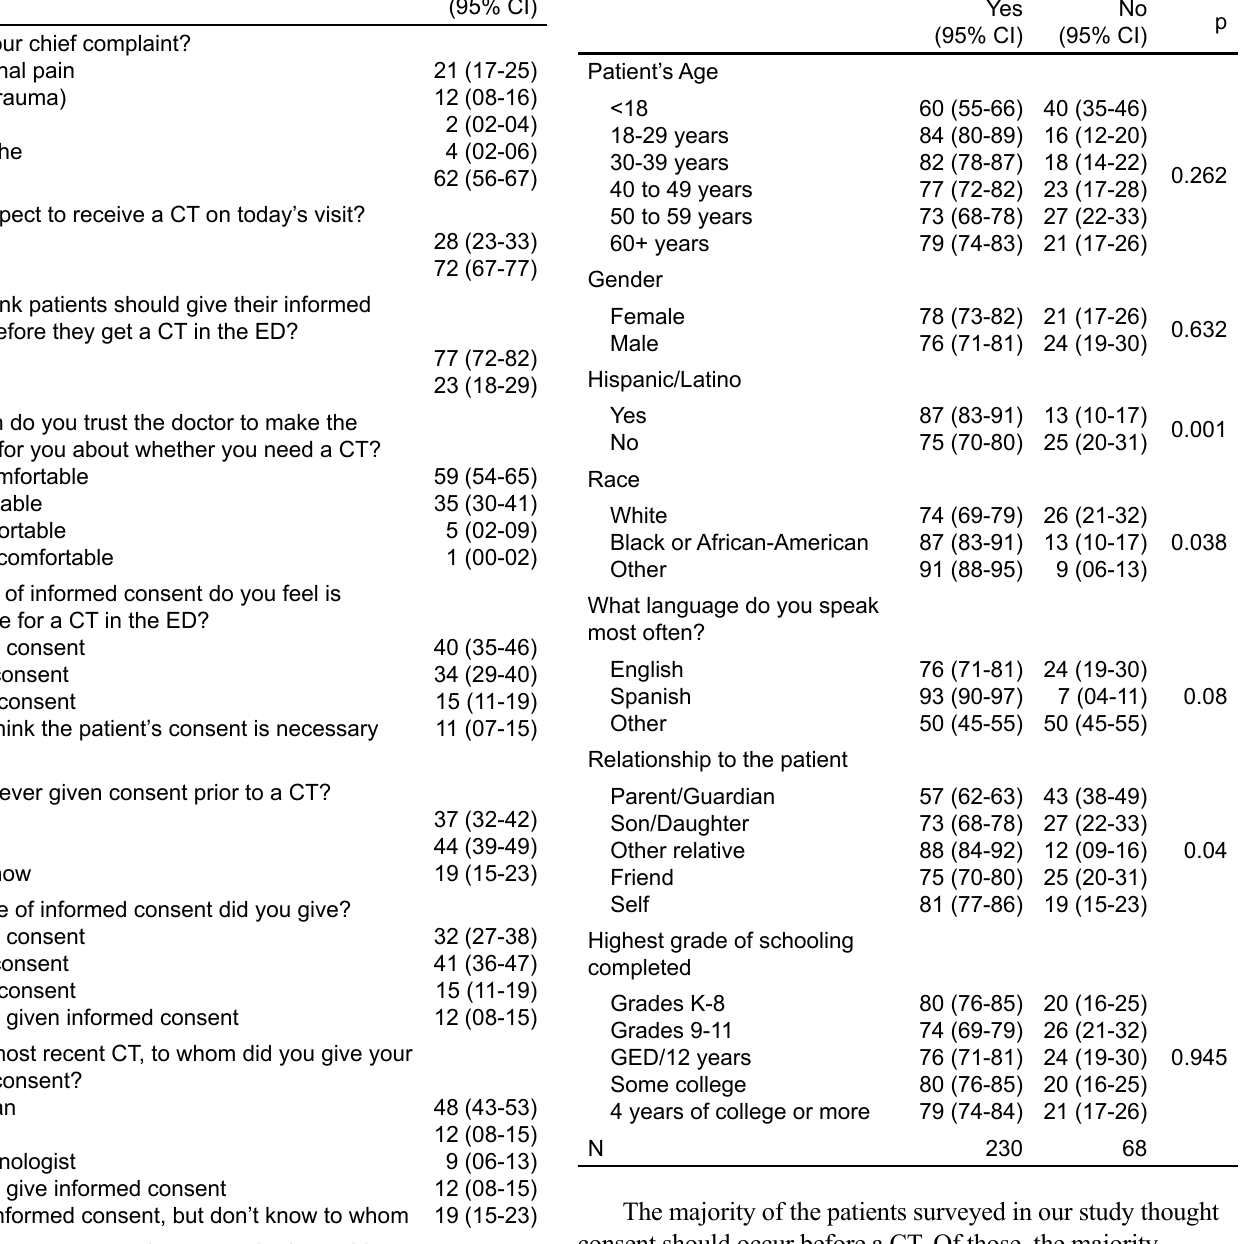
Table 2. Patient survey responses. Table 3. “Patients should give their informed consent” by selected demographic